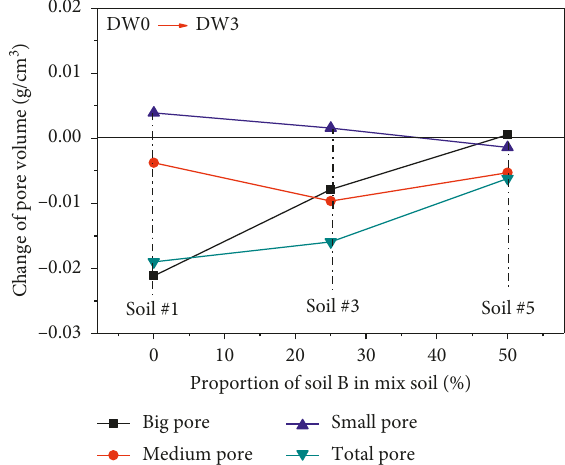
Figure 10: Pore volume change range of three CCLs from DW0 to